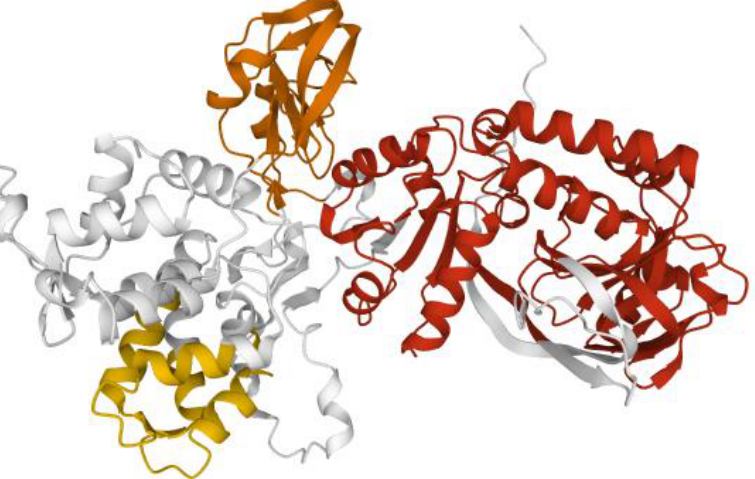
Figure 6. Model of DGK α . Model of DGK α structure from AlphaFold [15] rendered with the Mol* application [10] to show the two calcium binding EF hands (yellow), the two C1 domains (orange), and the split catalytic domain (red).